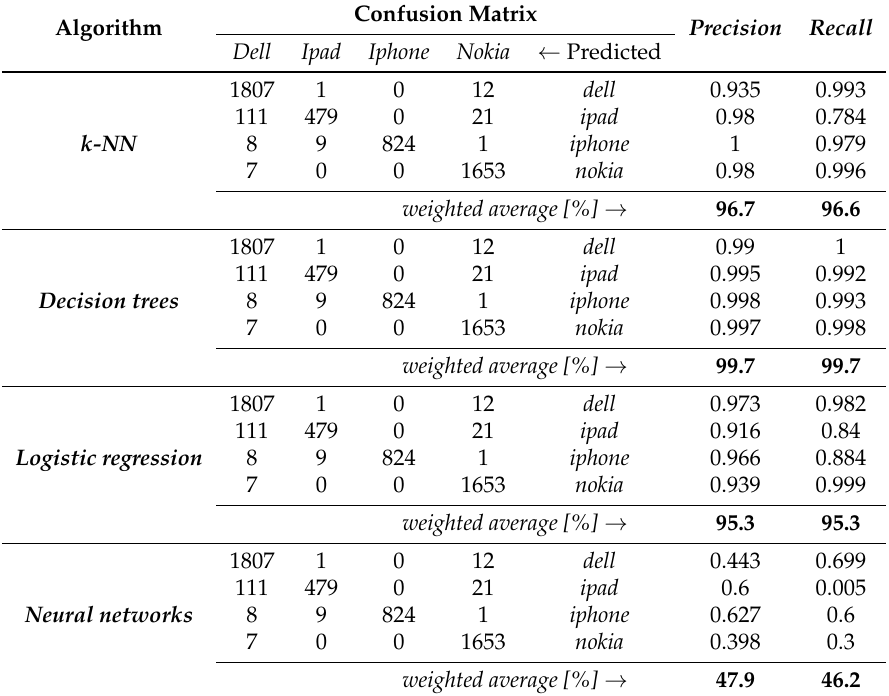
Table 11. Summarized classification performance for device type